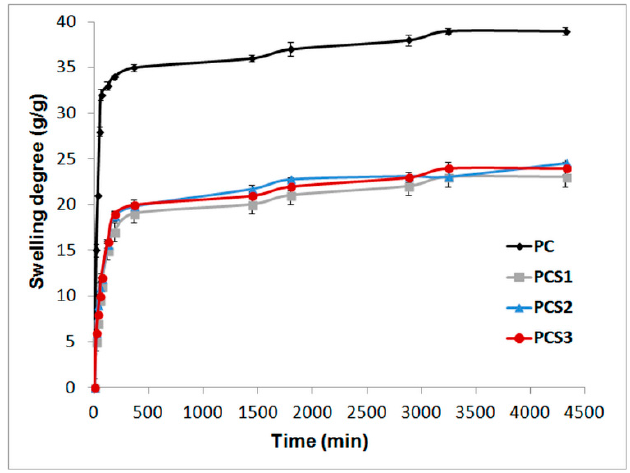
Figure 1. Swelling profiles of the composite samples.